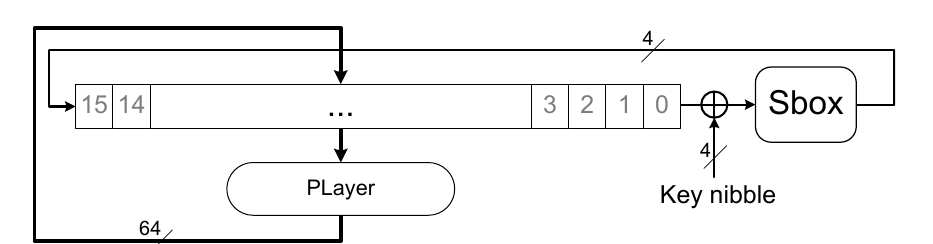
Figure 4: Nibble-serial architecture of the PRESENT block cipher, key schedule not shown.